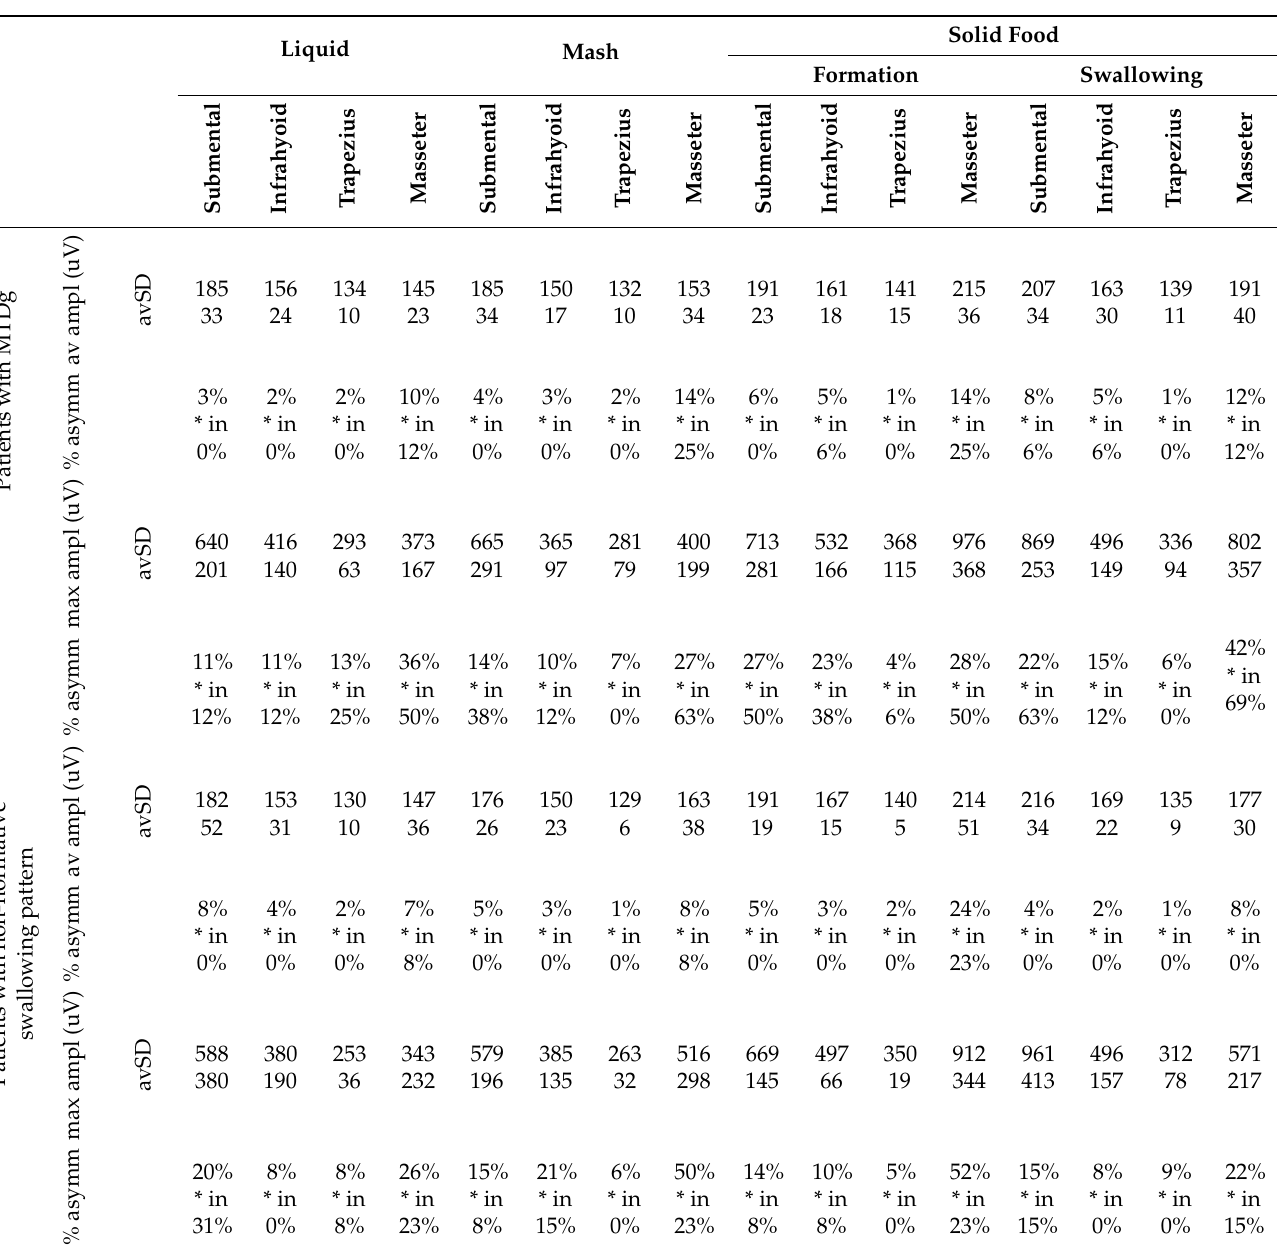
Table 3. Mean values of the average and maximum amplitude of the examined muscles with the percent of asymmetry between muscle pairs (right and left muscle). * refers to the percent of patients in the subgroup who exceeded the value of 20% of muscle amplitude